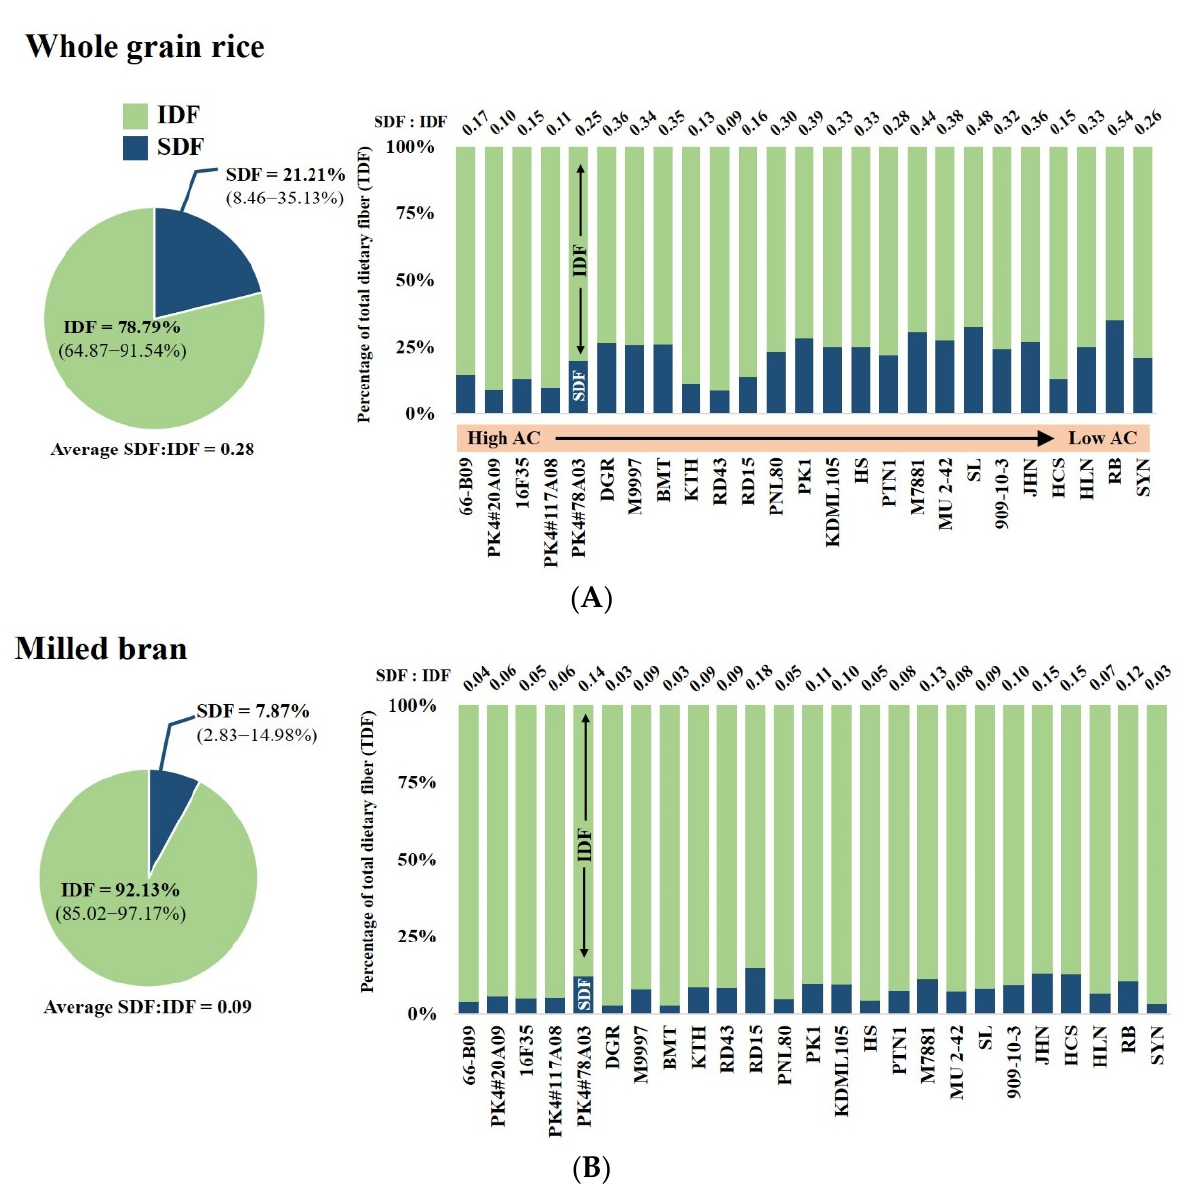
( D ) Figure 3. Overview of variation in SDF and IDF distribution ( A ) in whole grain rice samples varying from high amylose content (AC) to low AC, expressed as the percentage of total grain weight and ( B ) in milled bran samples expressed as the percentage of rice bran powder; the difference in ( C ) SDF or ( D ) IDF of whole grain non ‐ pigmented (NP) and pigmented (P) rice, expressed as the per ‐ centage of total grain weight. When the SDF to IDF ratio of whole grain rice was compared among the rice varieties, a wide variation was found, ranging from 0.1 (PK+4#20A09, 26.86% AC; PK+4#117A08, 26.69% AC; KTH, 21.73% AC, and RD43, 19.98% AC) to 0.5 (SL, 14.86% AC and RB, 13.96% AC) (Figure 4A, Table S3). Conversely, a slight difference was found in the SDF to IDF